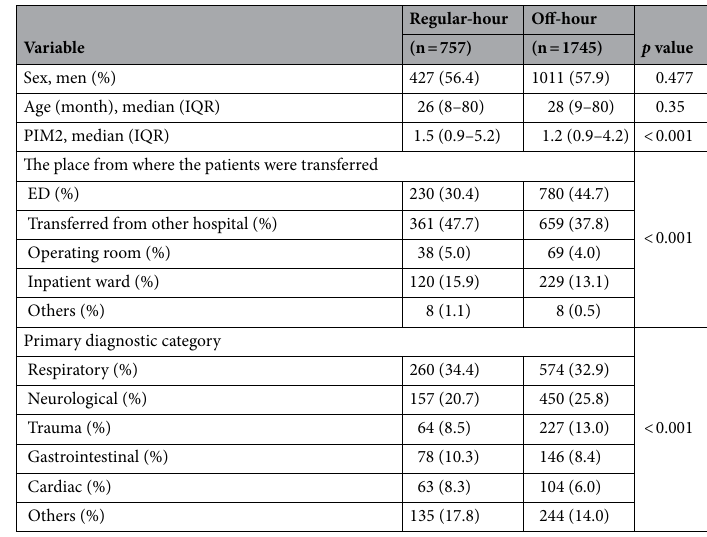
Table 1. Baseline characteristics of the patients. PIM2 Pediatric Index of Mortality 2, ED emergency department in the same hospital, IQR interquartile range. Comparisons between the groups were performed with the chi-squared test for categorical data and Mann–Whitney-U test for continuous data.